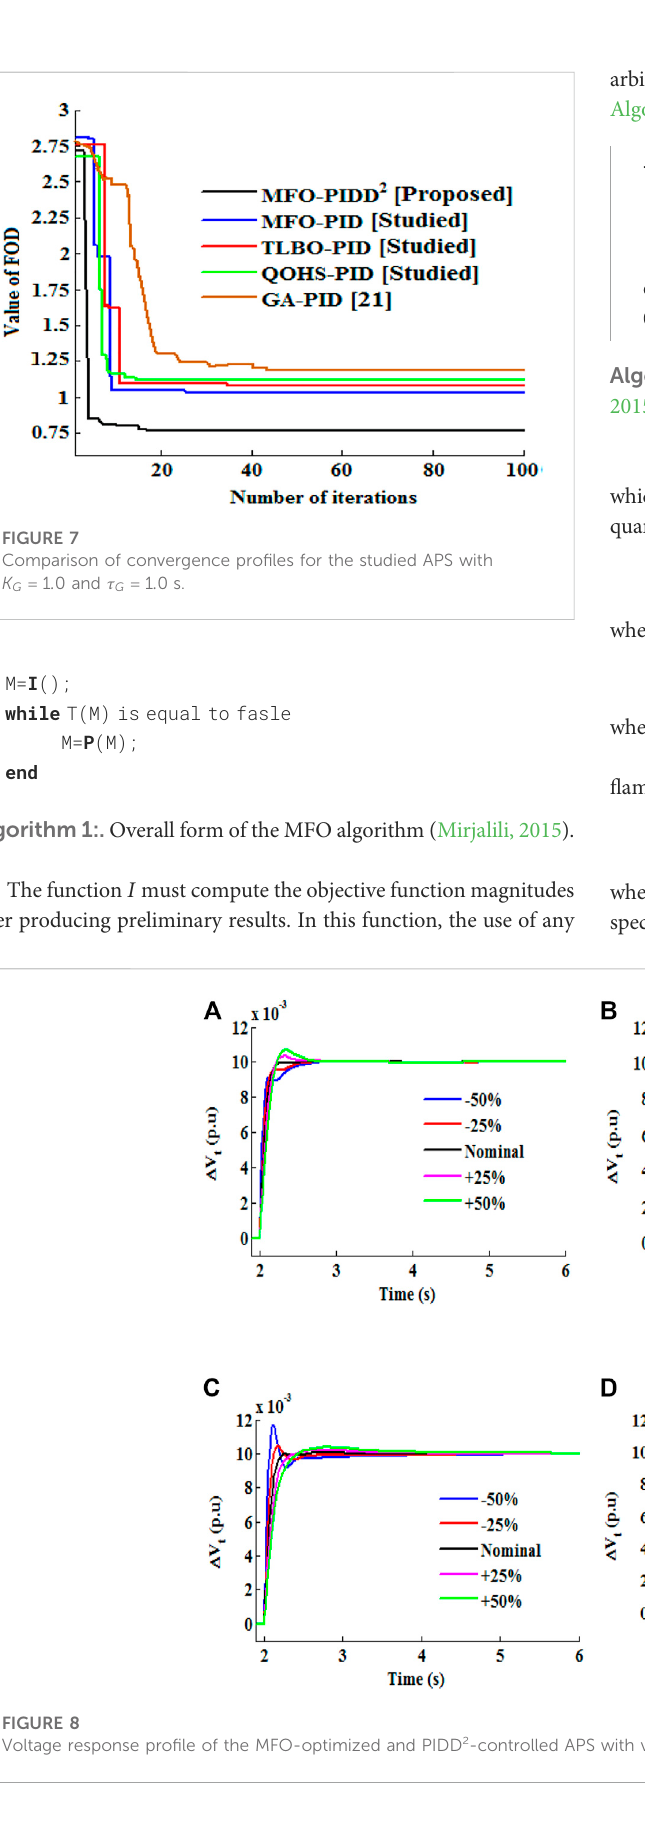
FIGURE 8 Voltage response pro fi le of the MFO-optimized and PIDD 2 -controlled APS with variations in- (A) τ A , (B) τ E , (C) τ G and (D) τ S .